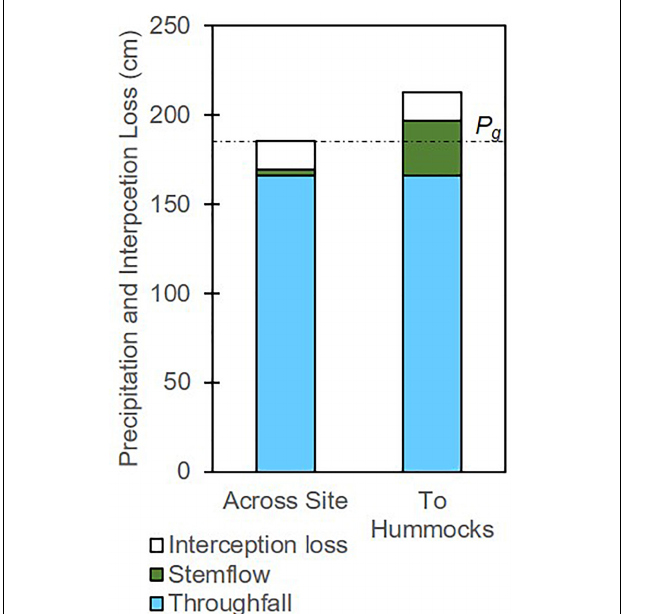
FIGURE 4 | Partitioning of precipitation among interception loss, stemflow, and throughfall across the site and across hummock area, assuming all shrub stemflow infiltrates into hummocks. The dotted line indicates the depth of gross precipitation across the study period, equal to the sum of across-site stemflow, interception loss, and throughfall, but exceeded by the sum of those values to hummocks (because of stemflow funneling in shrubs on hummocks).